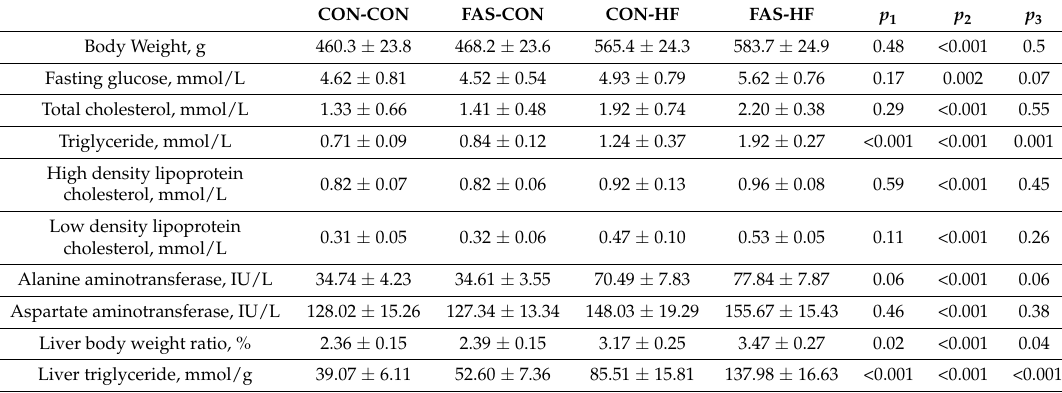
Table 1. Metabolic variables of male offspring at 15 weeks of age in different groups ( n = 10). Table S2. β -actin was used as a reference gene for normalization in each reaction. Relative expression differences were calculated using the 2(-Delta Delta C(T)) method [19].